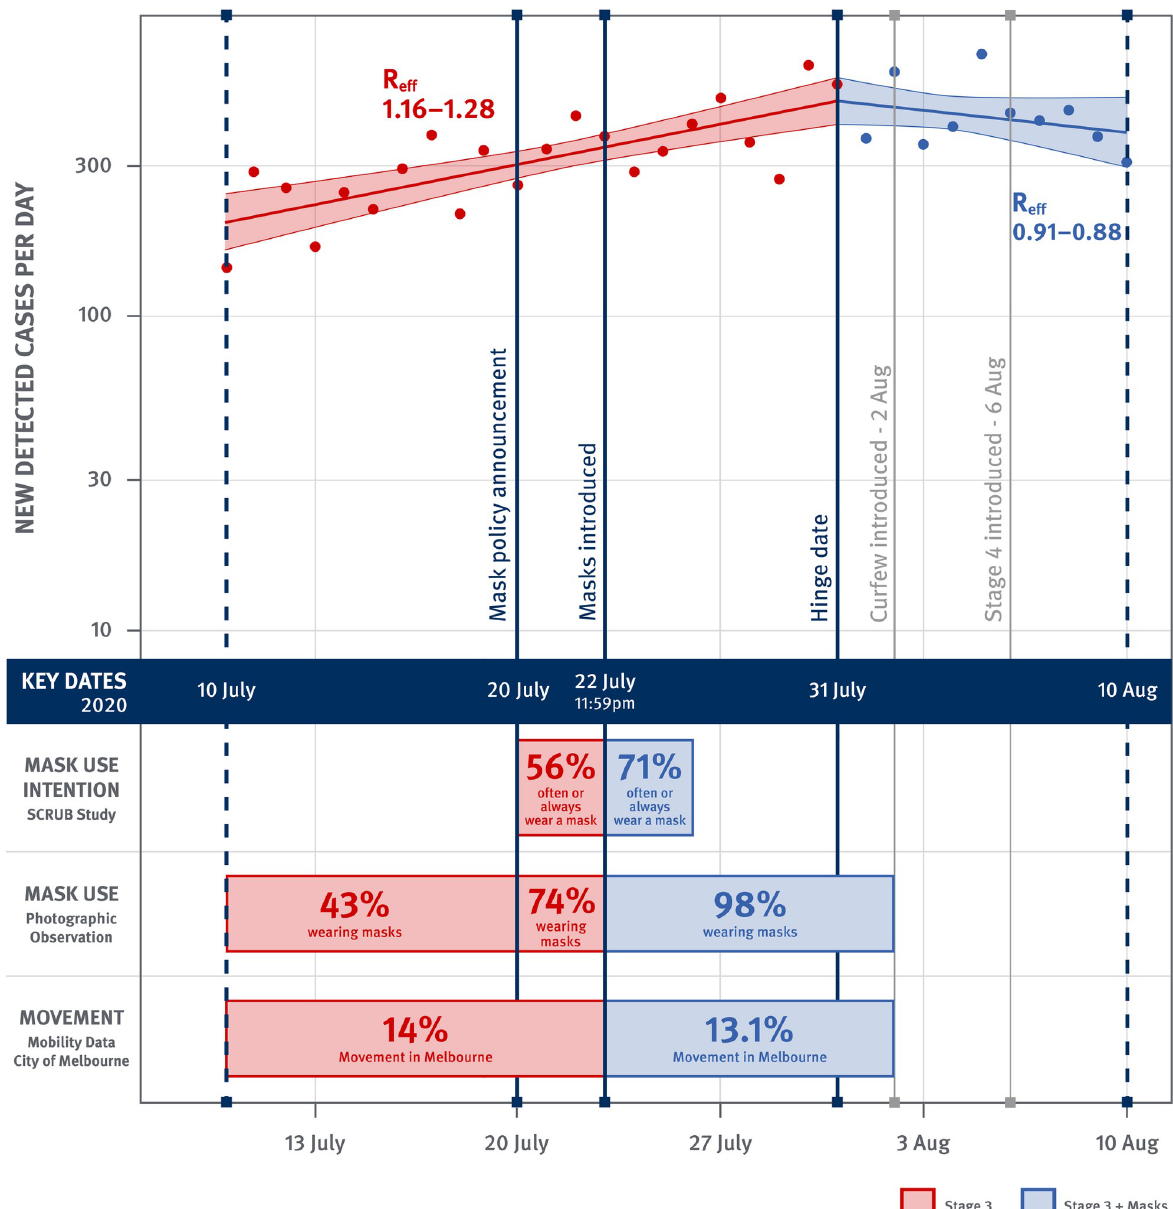
Fig 1. COVID-19 cases detected per day in Victoria. Observed daily cases (dots) and fitted linear spline model with a hinge day on 31st July, with shading representing upper and lower 95% confidence interval of the fitted curves. Red: analysis period for pre-masks; Blue: analysis period for